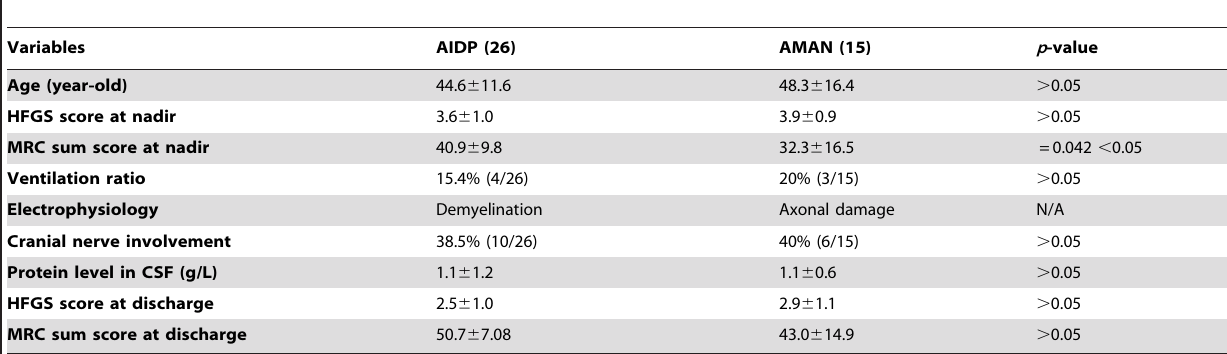
Table 4. Comparisons of clinical features between AIDP and AMAN patients in the ganglioside 2